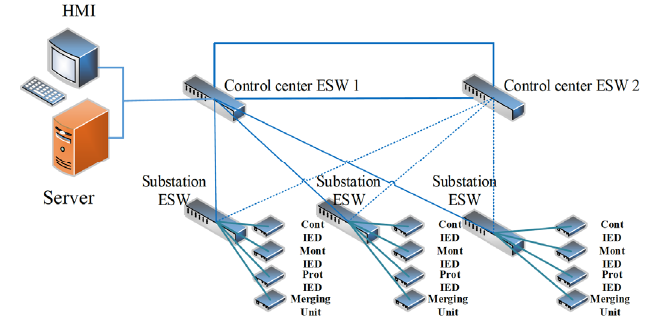
Figure 4. A typical star-ring topology of the cyber